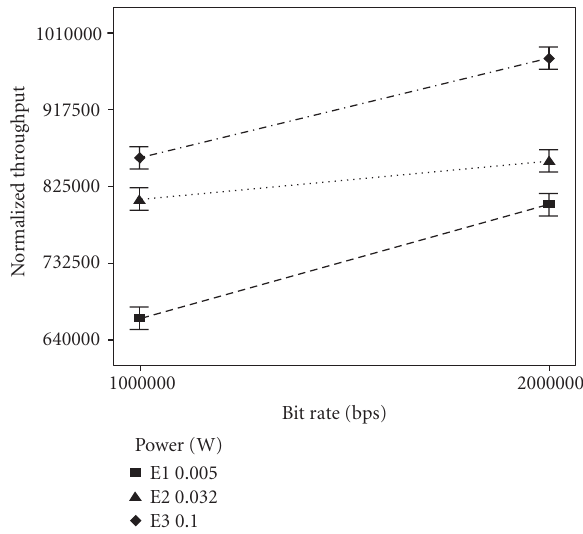
Figure 14: Analysis of power and data rate’s impact on FTP